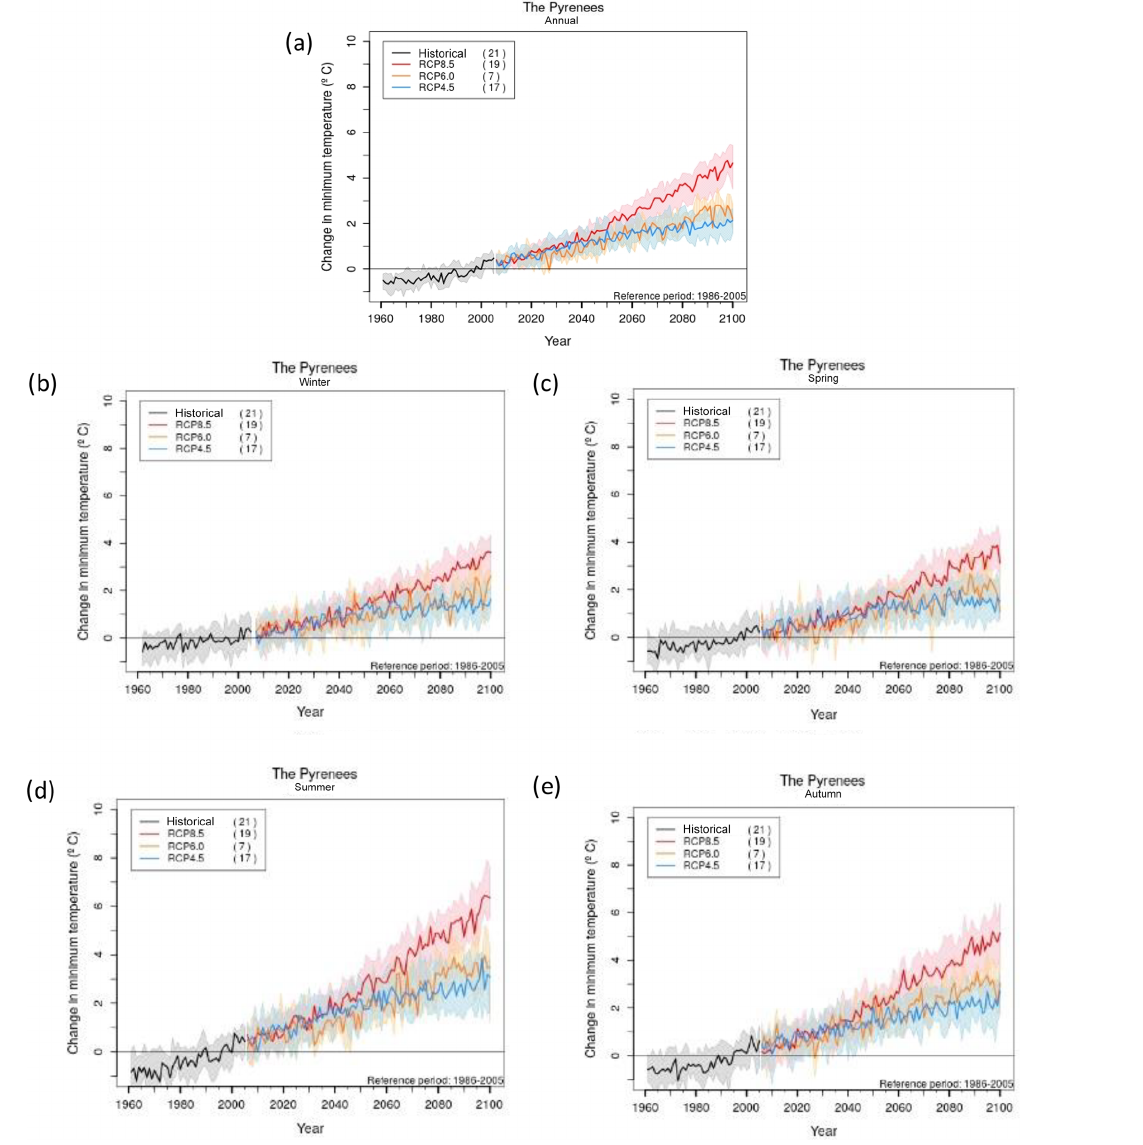
Figure 5. The same as Fig. 3 but for minimum